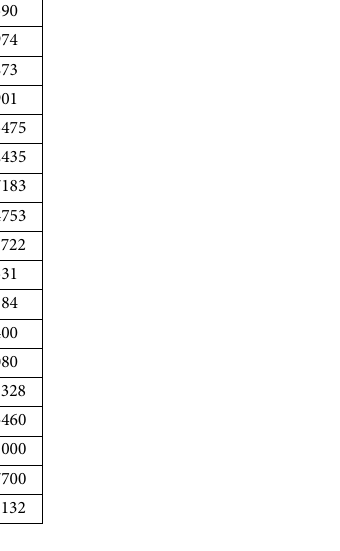
Table 2. Analysis of orthogonal experimental